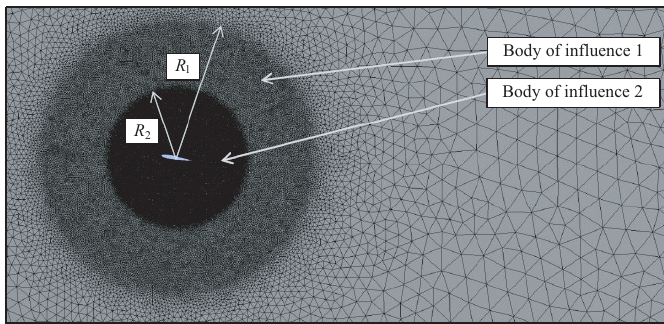
Figure 12. Bodies of influence applied to the mesh.